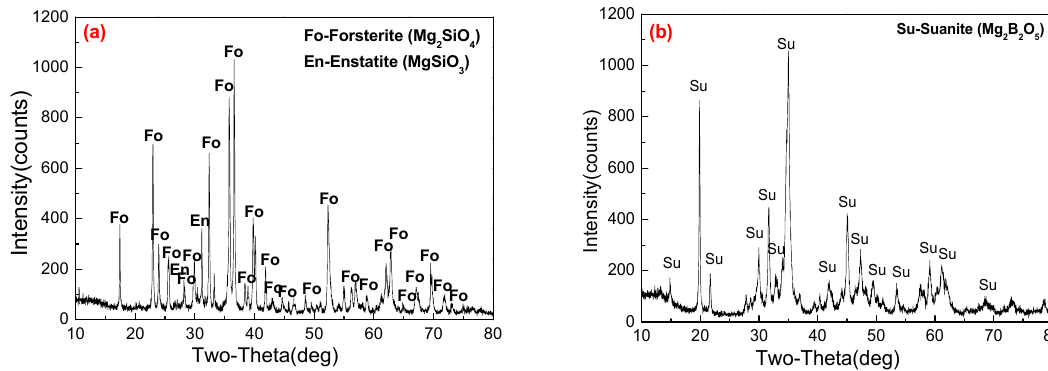
Figure 2. XRD results of the roasting products of lizardite ( a ) and szaibelyite ( b ).